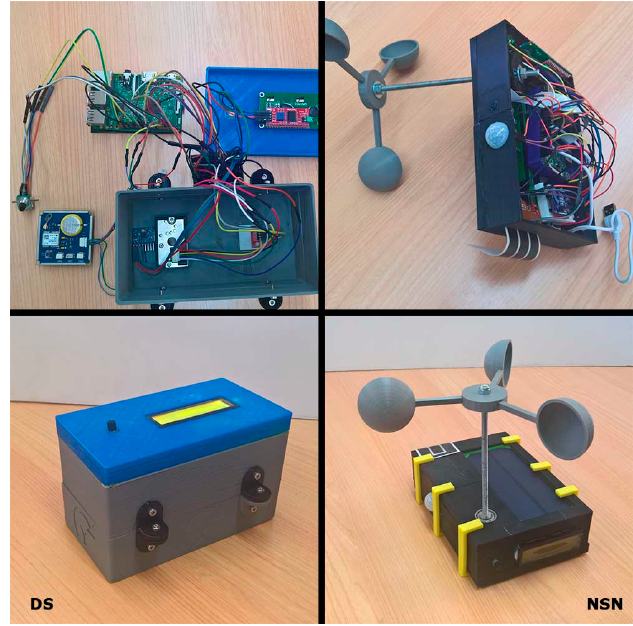
Figure 10. Picture of the implemented sensing system prototype.